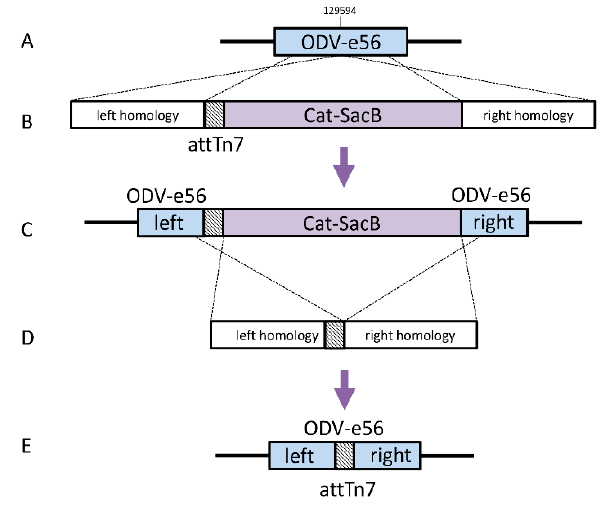
Figure 3. Construction of bacmids with relocated attTn7. ( A ) Parent strain; ( B ) linear attTn7 removal cassette; ( C ) intermediate Cat-SacB strain; ( D ) linear removal marker; ( E ) final strain.